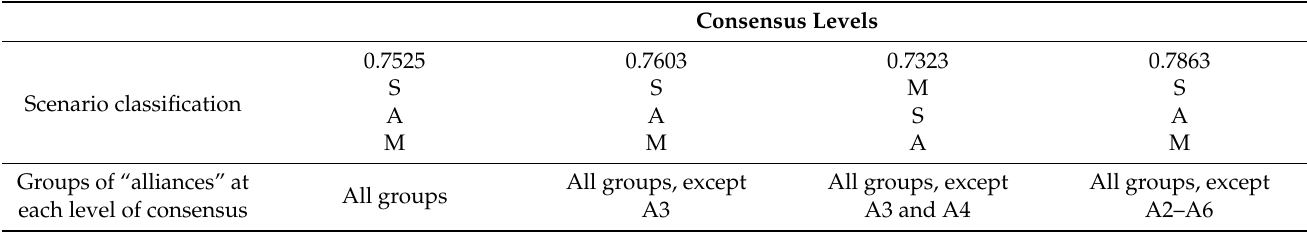
Table 4. Priorities between scenarios based on the level of